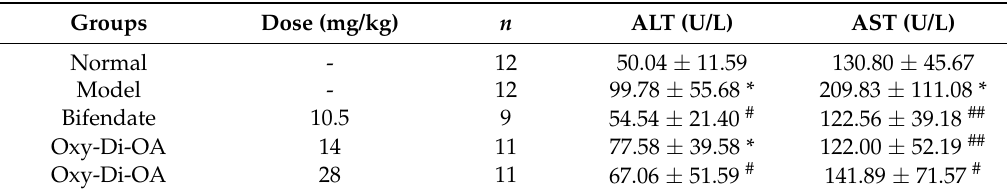
Table 1. Effects of Oxy-Di-OA on serum alanine aminotransferase (ALT) and aspartate aminotransferase (AST) (mean ± SD).